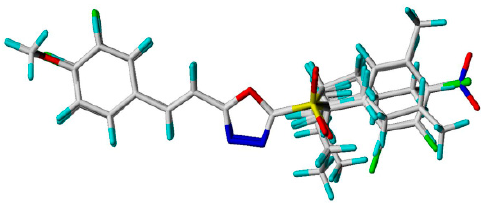
Figure 5. Alignment of training compounds.